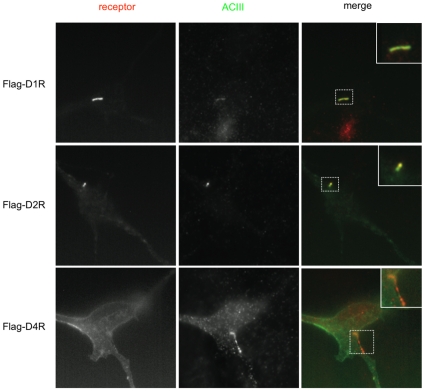
Subtype-selective localization of dopamine receptors to cilia in striatal neurons.Examples of ciliary localization of Flag-D1R and Flag-D2R, but not Flag-D4R, in primary striatal neurons. The left panels indicate surface Flag immunoreactivity marking receptors present in the plasma membrane. Middle panels indicate ACIII immunoreactivity marking cilia. The merged image is shown in the right panels, with the region of cell body containing the cilium displayed at higher magnification in the inset.